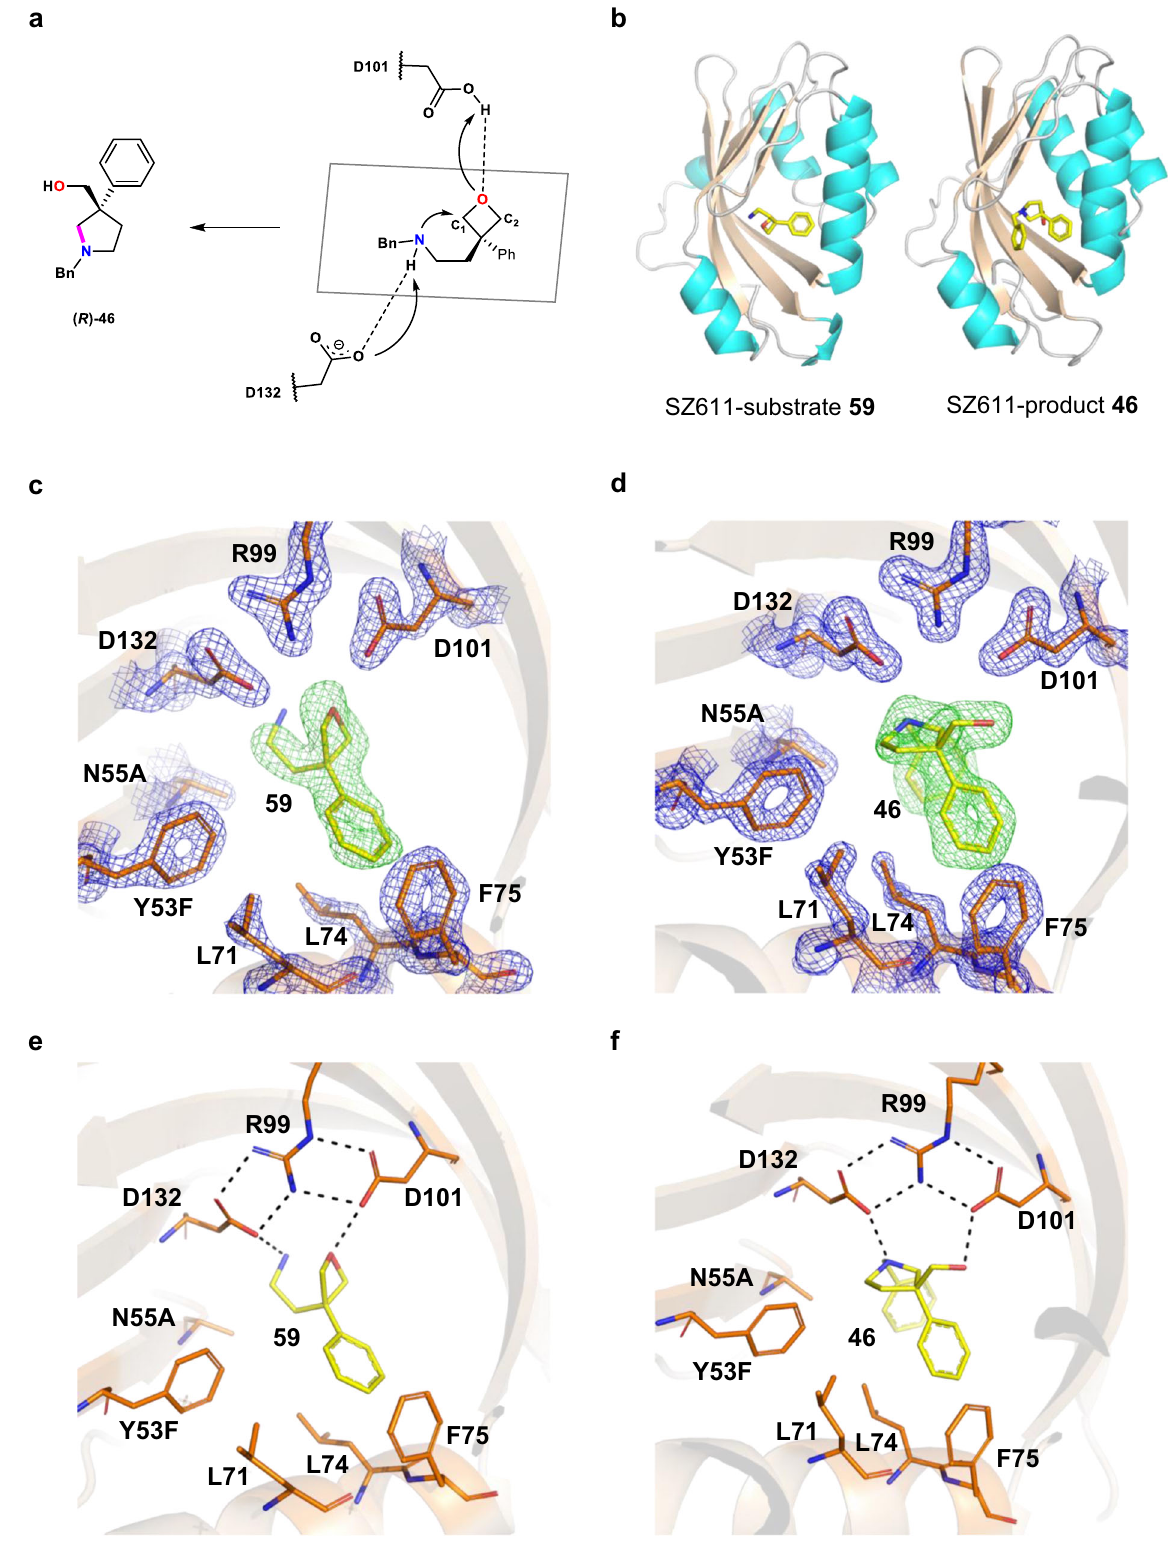
Fig.7|StructuralanalysisofthedesignedmutantSZ611.a Proposedmechanism of LEH-catalyzed selective desymmetrization reactions of oxetanes. b Overall structureofLEHboundtosubstrate 59 andproduct 46 (yellow). c Electrondensity forsubstrate 59 . d Electrondensityforsubstrateproduct 46 ,Fo-Fcmapcontoured